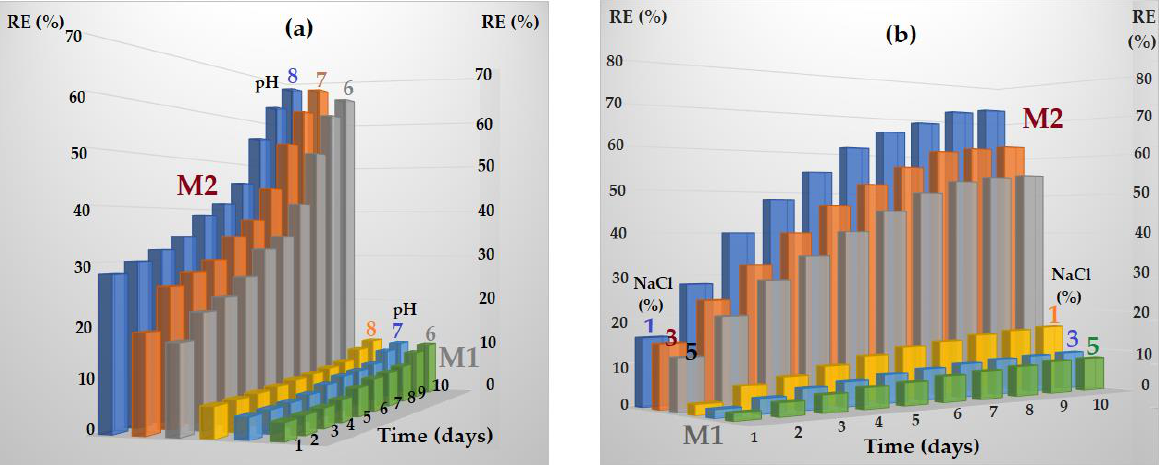
Figure 15. Time variation of melatonin cumulative release through sulfonated ethylene-propylene- diene terpolymer (sEPDM) membrane (M1) and chitosan-sulfonated ethylene-propylene-diene ter- polymer (Chi-sEPDM) membrane (M2), depending on pH ( a ) and salinity ( b ). The results obtained for the release of melatonin show that chitosan-sulfonated eth- ylene-propylene-diene terpolymer (Chi-sEPDM) membrane (M2) allows a faster transfer